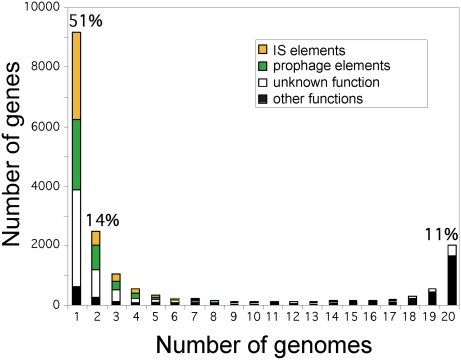
Frequency of genes within the 20 analysed Escherichia coli genomes.At one extreme of the x-axis are the genes present in a single genome which are regarded as strain specific genes (9054 genes: 51% of the pan-genome), while at the opposite end of the scale are situated the genes found in all 20 genomes, which represent the E. coli core-genome (1976 genes: 11% of the pan-genome). Coloured rectangles represent the proportion of insertion sequence (IS)-like elements (yellow), prophage-like elements (green), and genes of unknown/unclassified function (white). Black rectangles represent genes for which a function can be assigned. Strain-specific genes correspond to 2885 IS-like elements (32%), 2352 prophage-like elements (26%), and 3220 genes of unknown/unclassified function (35%).